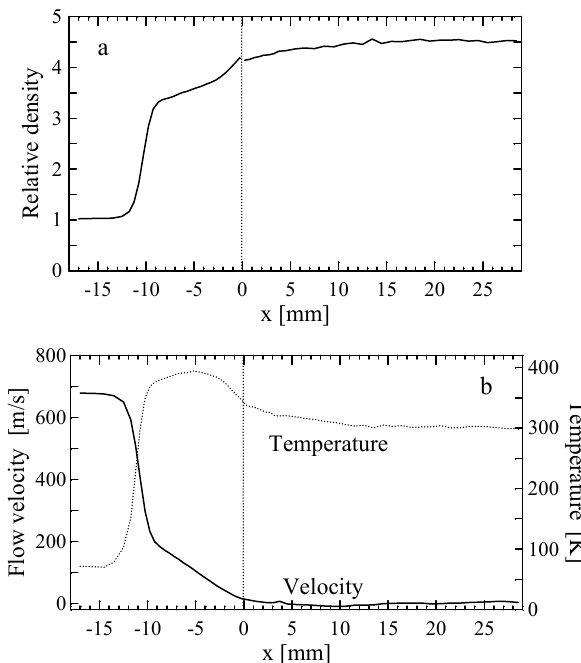
Fig. 6. Simulated density fields N/N ∞ for the flow towards a semi- closed instrument structure (a) with and (b) without attached mesh. Freestream conditions are the same as in the wind tunnel p ∞ = 2 . 6 Pa, c ∞ = 678 ms − 1 and T ∞ = 71 K.